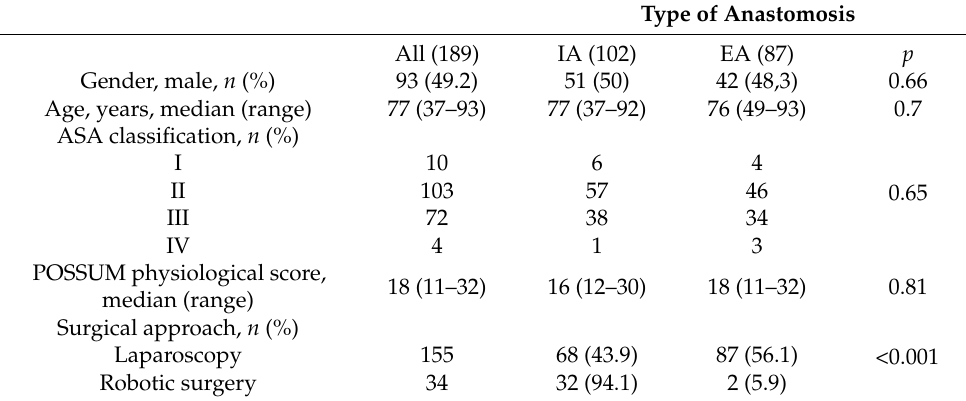
Table 1. Baseline characteristics.